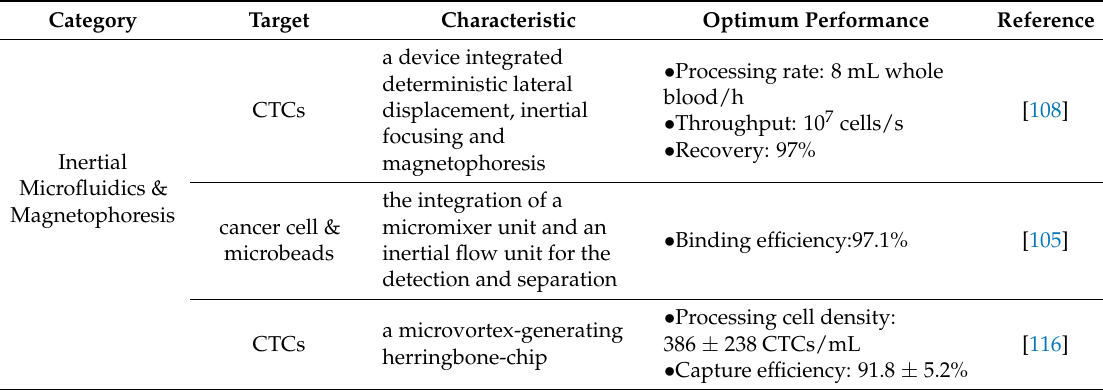
Table 4. Typical progresses of inertial microfluidics integrated with other